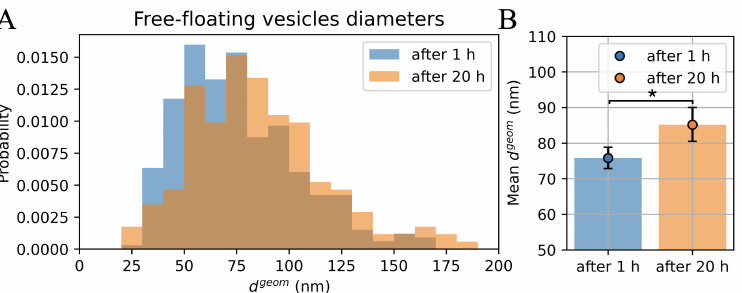
Figure 2. The exosome diameter as a function of imaging time: ( A ) histograms of the geometric diameters of exosomes isolated from PC3 cells, obtained on the basis of AFM images after 1 h (blue) and after 20 h (orange); ( B ) relevant mean values of vesicle diameters (blue and orange dots) together with a 95% CI obtained by bootstrapping; * means that 95% CI of the two outcomes do not